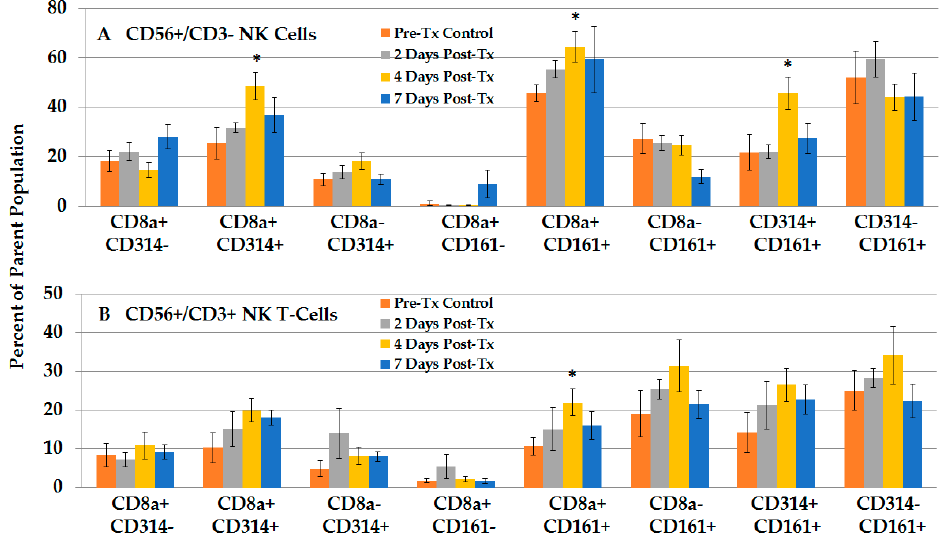
Figure 6. NPS induces an increase in various phenotypic subsets of NK and NKT-cells. Liver lymphocytes were analyzed with CD8a, CD314 (NKG2D) and CD161 on ( A ) NK cells (CD56+/CD3 − ) and ( B ) NKT-Cells (CD56+/CD3+). Naïve n = 4, Pre-Tx n = 5; others n = 6; error bars = SEM. * p < 0.05. (CD56+/CD3+). Naïve n = 4, Pre-Tx n = 5; others n = 6; error bars = SEM. * p <